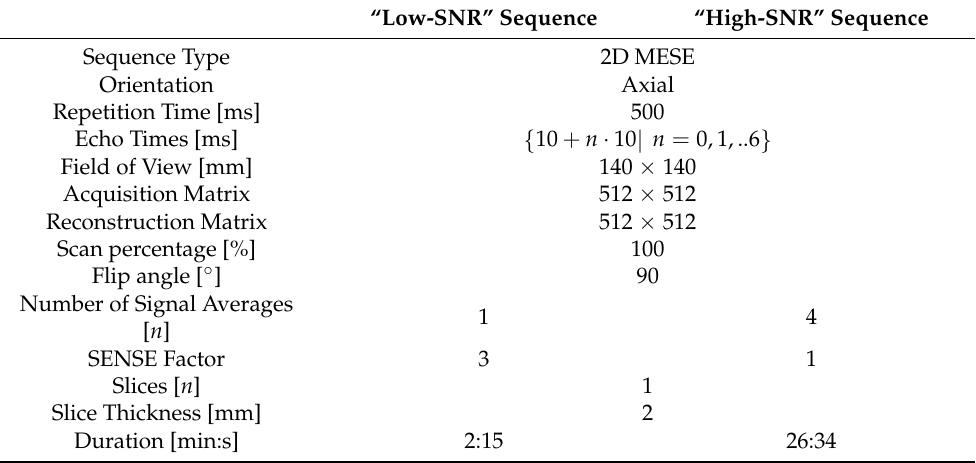
Table 1. MRI acquisition parameters for the “low-SNR” and “high-SNR” multi-echo spin-echo sequences. Please note that although 10 echo times were initially sampled, only the first 7 echoes were used for the T2 fitting because of insufficient SNRs in the last echoes. The choice of echo times was guided by the Osteoarthritis Initiative study [39]. Abbreviations: MESE = Multi-echo spin-echo, SENSE = Sensitivity